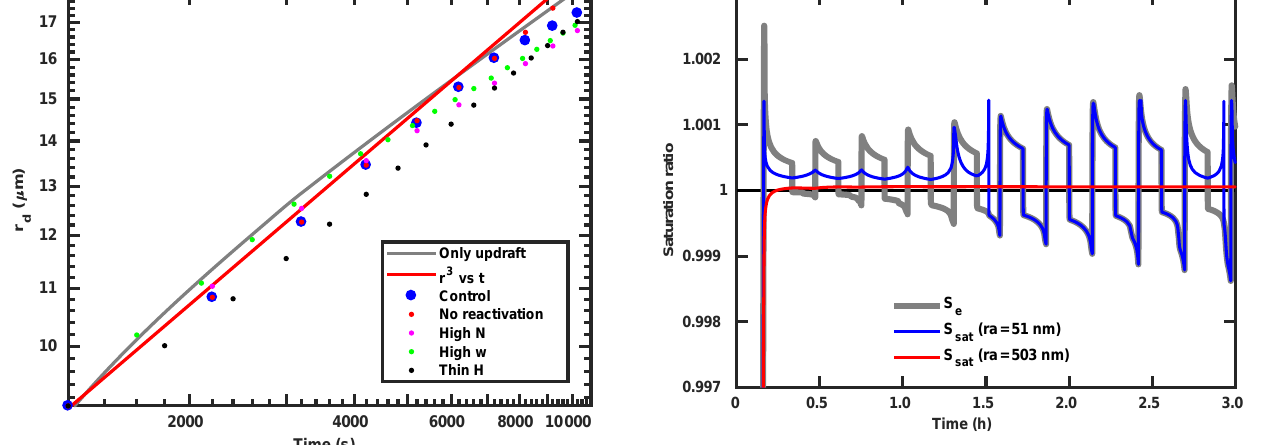
Figure 8. The largest cloud droplet size after each cycle is plotted for the different previously discussed cases: blue dots, control case; red dots, no reactivation case; pink dots, high number concentration case; green dots, high vertical velocity case; and black dots, thin oscillation layer case. The gray line is for the ascending-only case from Fig. 4, and the red line represents the growth of a droplet.